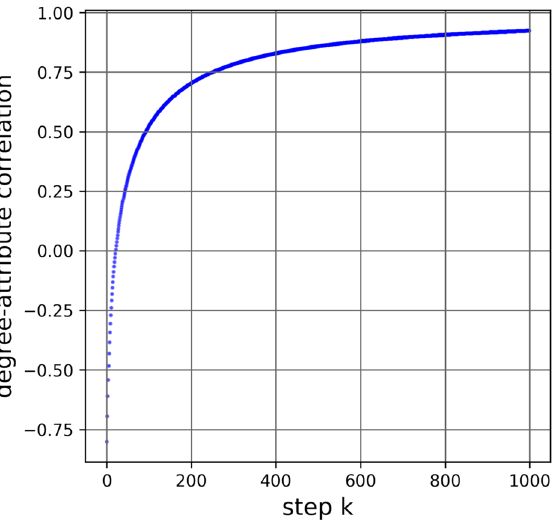
Figure 3. Degree-attribute correlation for the 8-node example in Fig. 1 as we add pairs of triple-2 and triple-3